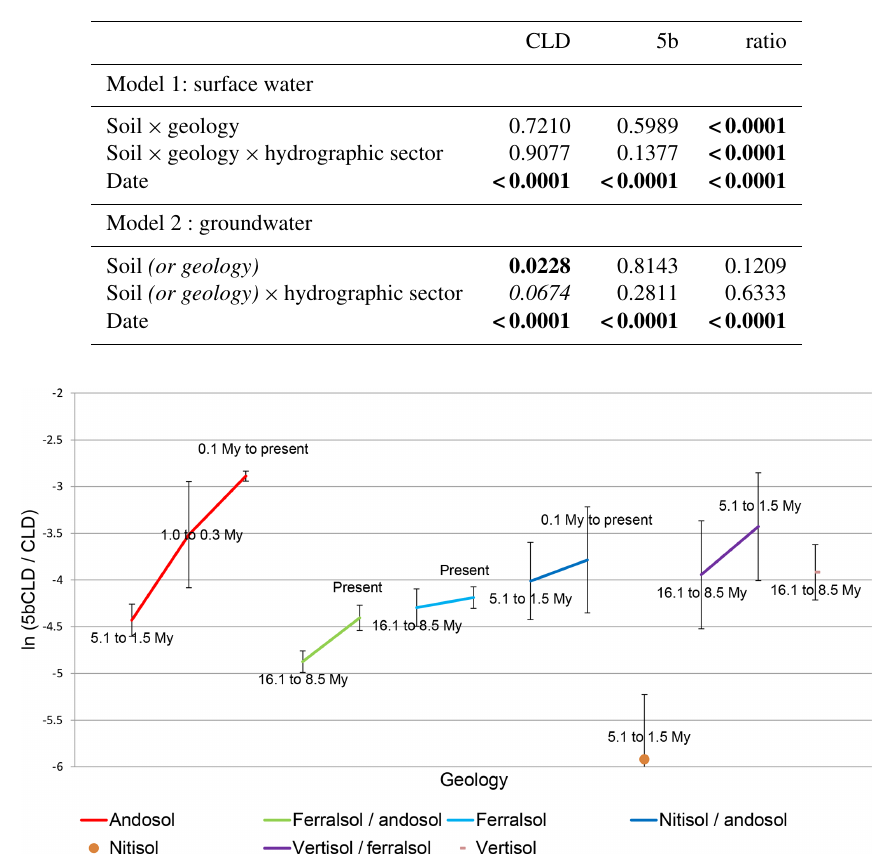
Table 1. Effects of physical conditions on the contamination level of surface water (model 1) and groundwater (model 2), showing probability levels of tested factors. Bold: statistically significant at the 0.05 probability level. Italics: statistically significant at the 0.10 probability level.